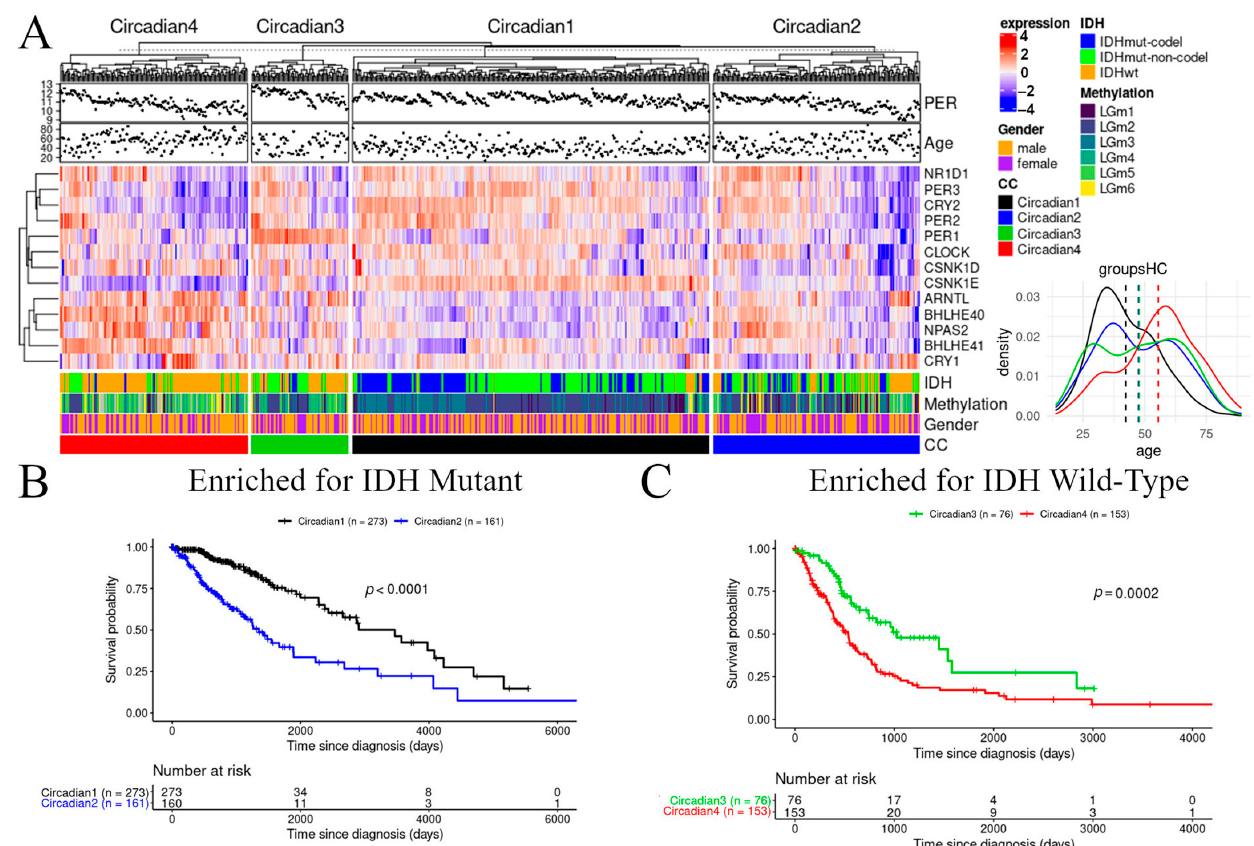
Figure 1. Prognostic relevance of PER in unsupervised clusters in the TCGA dataset. ( A ) Unsupervised clustering of patient samples identifies 4 clusters: one with enriched for IDH mutated samples and high PER expression (Circadian1, black), one with enriched for IDH -mutated samples and low PER expression (Circadian2, blue), one enriched for IDH wild-type samples and high PER expression (Circadian3, green), and one enriched for IDH wild-type and low PER expression (Circadian4, red). The heatmap shows the upregulation (red) and downregulation (blue) of clock genes for each cluster (Circadian1–4), as well as annotation bars for patient sex and TCGA methylation classes of the samples. Inlet graph demonstrates age distribution across the clusters. ( B , C ) Kaplan–Meier curves for clusters enriched for IDH -mutant ( B ) and IDH wild-type ( C ). Favorable prognosis was associated with a higher PER expression regardless of the IDH mutation composition.